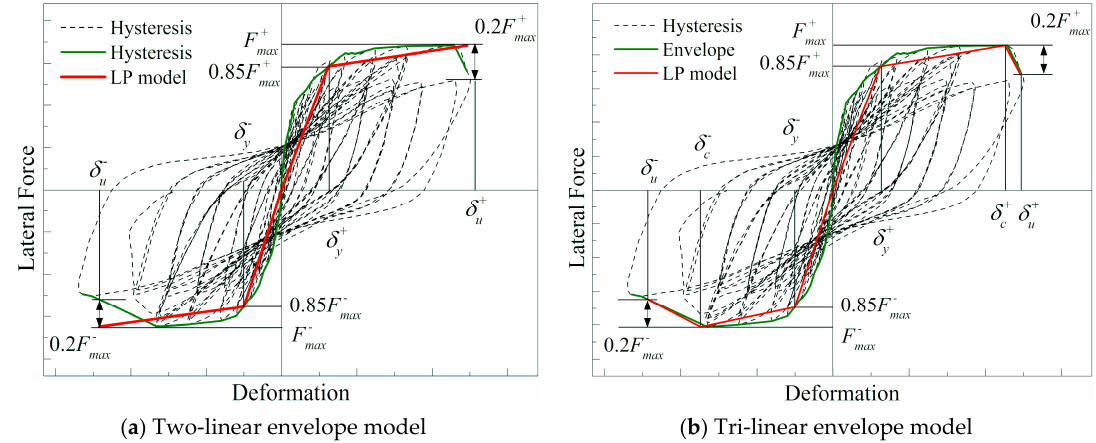
Figure 2. Schematic of hysteretic curves and definition of strength and deformation capacities.